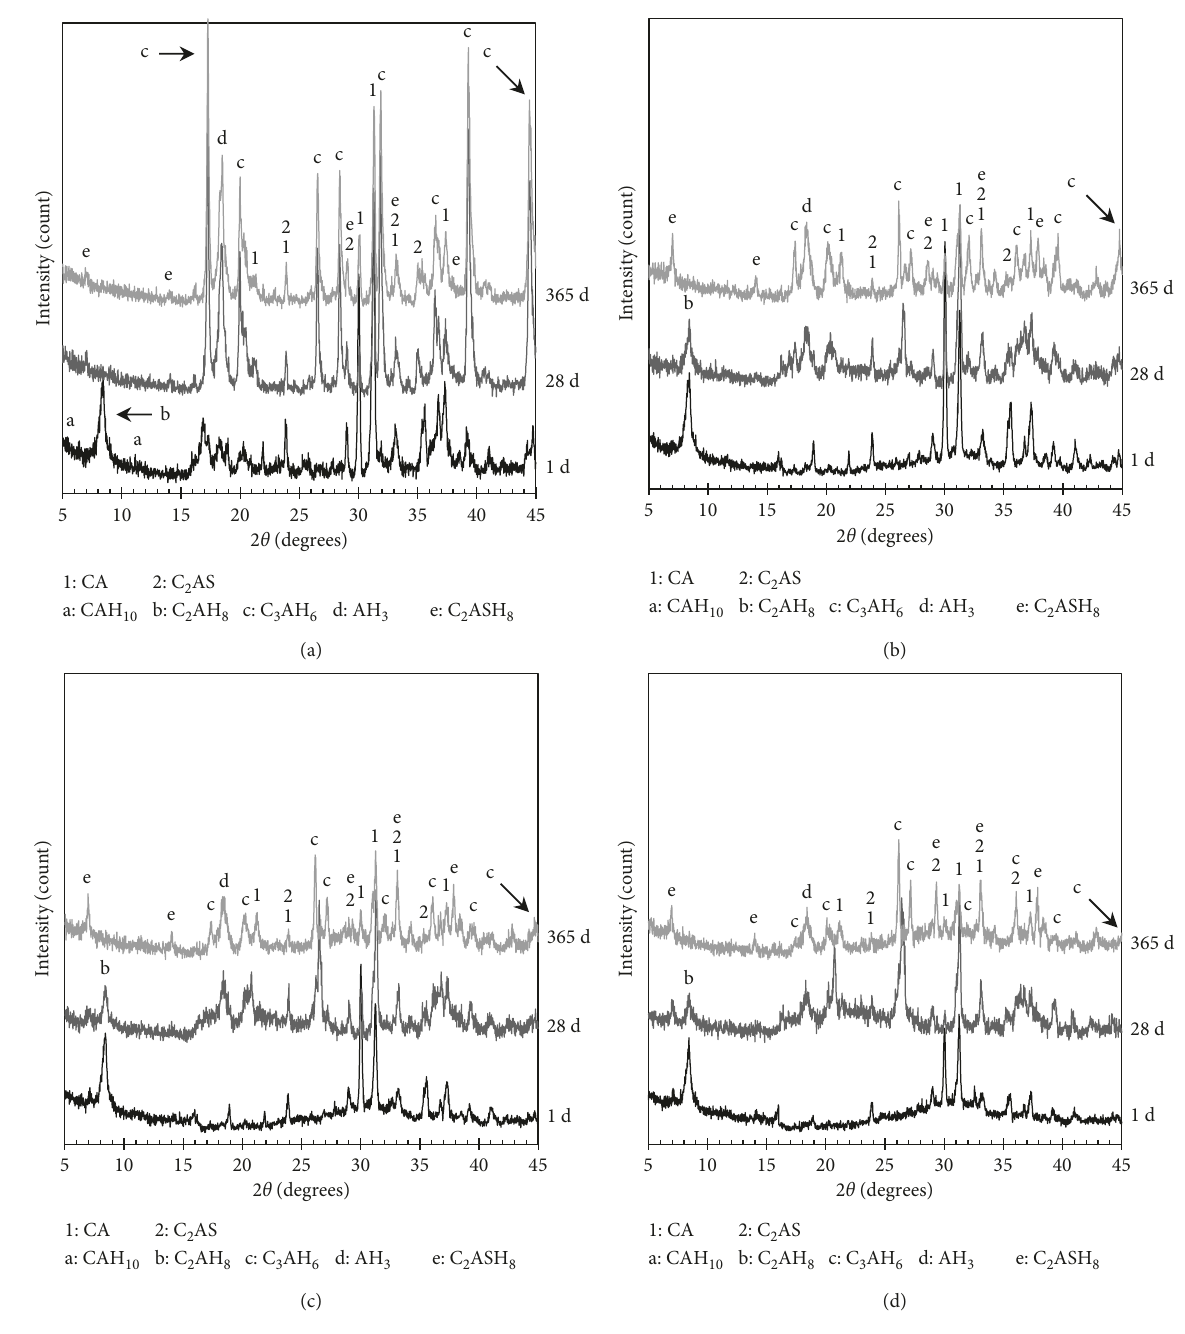
Figure 4: XRD curves for paste of CAC-GGBS mixtures at 0.4 of W/B with time: (a) CAC 100; (b) CAC 80; (c) CAC 60; (d) CAC